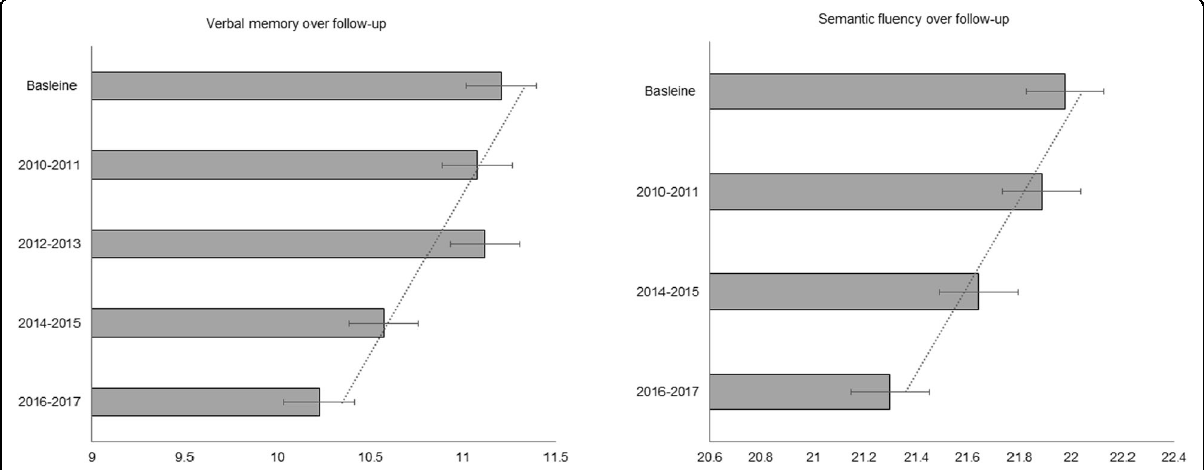
Fig. 1 Distribution of the cognitive domains across all waves of data collection for the 6817 ELSA participants included in this study presented as means and standard deviations. The baseline data were obtained from either wave 2 (2004 – 2005) for the core members who started at wave 1, or wave 4 for the participants joining the study at wave 4 through the refreshment sample. Follow-up data were ascertained from waves 4 (2009 – 2010) to wave 8 (2016 – 2017), which is the latest wave of data